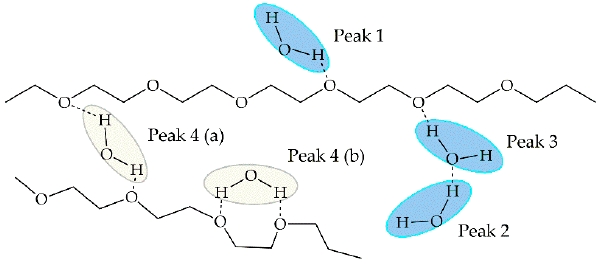
Figure 10. Proposed structure of water on hydrated PEG as shown in [56]. Intermediate water showed in blue; non-freezable water showed in yellow. Reprinted with permission from Langmuir 2001, 17, 1889–1895. Copyright 2001 American Chemical Society.